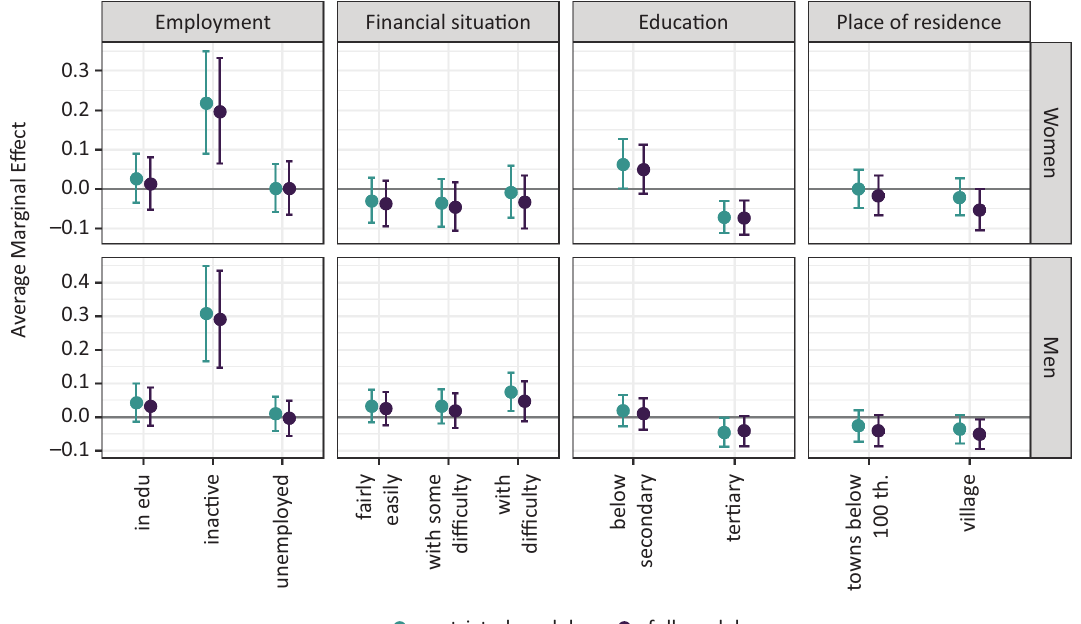
Figure 4. Effects of socioeconomic characteristics on intention to remain childless. Notes: AMEs of intending to remain child‐ less (vs. reference category: intending children in the future) in restricted models (M2‐M5) and full model (M6) together with 95% confidence intervals. AMEs expressed on the scale of the response variable (as changes in probabilities) from logistic models M1–M6 estimated jointly for women and men. Reference categories: education (M2 & M6):